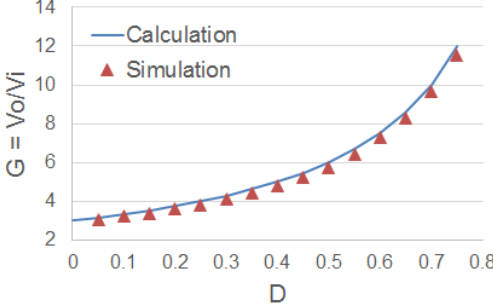
Figure 13. Voltage gain comparison between calculation and simulation.